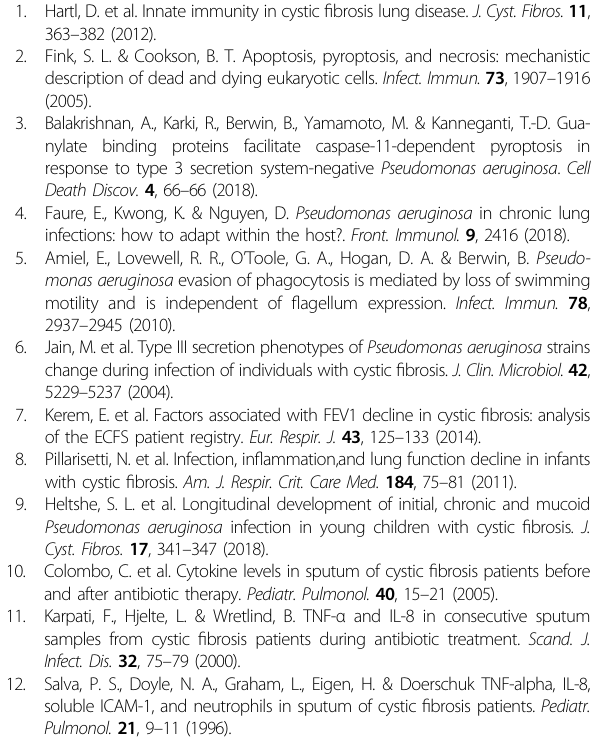
Fig. 8 PA14 and S. aureus demonstrate an inverse relationship between cell death and cytokine expression. THP-1 macrophages were seeded as described in Fig. 1 and infected with either PA14 or S. aureus 6538 at various MOIs. Three hours postinfection, cell viability via neutral red and TNF and IL-1 β in the supernatant via ELISAs were measured ( A ). Infections were also performed using an MOI of 1, and cell viability and cytokines were measured at 1-h intervals for up to 3 h ( B ). Mean ± SD of triplicates of a representative experiment are